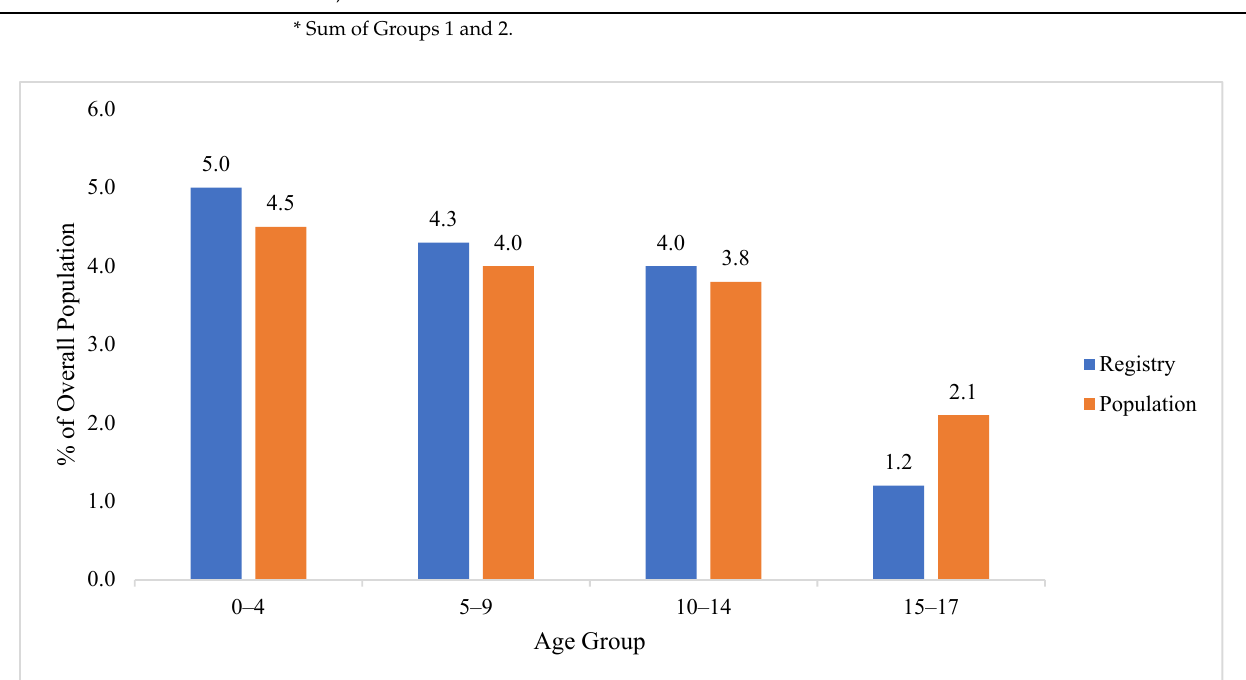
Figure 2. Comparison of proportions by age group of WTCHR (Registry) children to population south of Canal Street in Lower Manhattan in 2000.